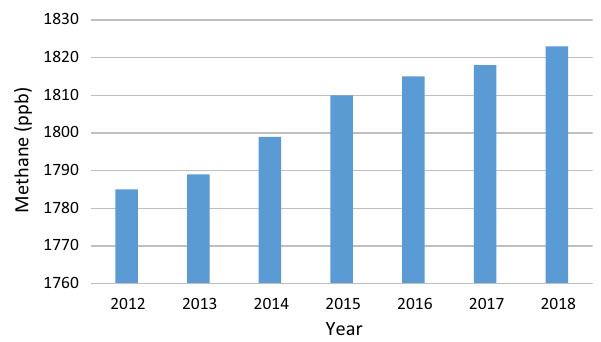
Fig. 1 Methane change trends from 2012 to 2018